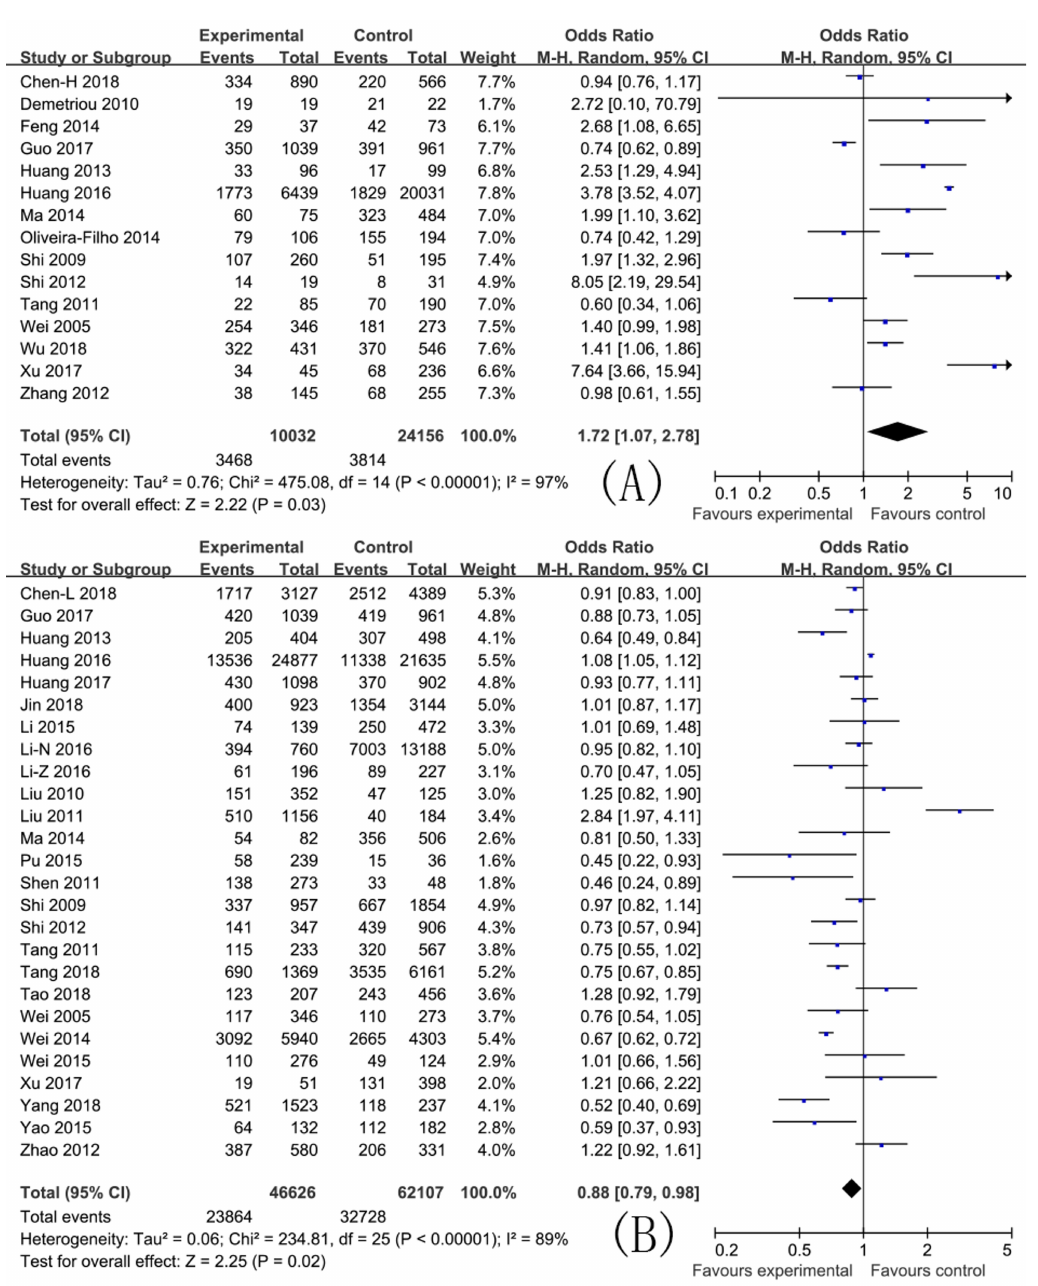
Figure 2. E ff ects of pooled ORs for factors correlating to the development of HCV infection among drug users (( A ) sexual behavior without a condom; and ( B ) married or cohabiting with a regular